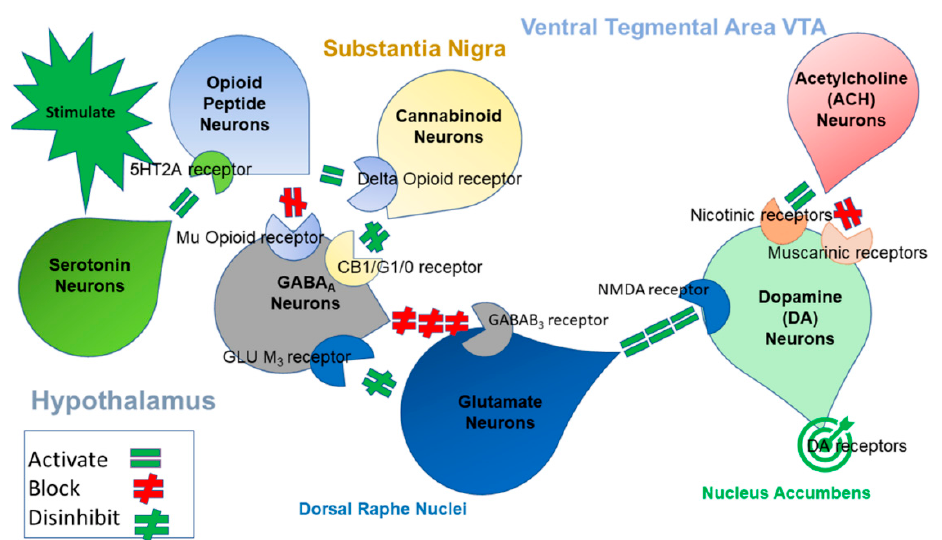
Figure 1. illustrates the interaction of at least six major neurotransmitter pathways involved in the brain reward cascade (BRC). In the hypothalamus, environmental stimulation causes the release of serotonin, which in turn, via, for example, 5HT-2a receptors, activates (the green, equal sign), the subsequent release of opioid peptides into the hypothalamus. Then, the opioid peptides have two distinct effects, possibly via two different opioid receptors. (A) inhibits (the red hash sign) through the mu-opioid receptor (possibly via enkephalin) and projects to the substantia nigra to GABA A neurons. (B) stimulates (the green, equal sign) cannabinoid neurons (e.g., anandamide and 2-archy- donoglcerol) through beta-endorphin linked delta receptors, which in turn inhibit GABA A neurons at the substantia nigra. cannabinoids, primarily 2-archydonoglcerol, when activated, can also indi- rectly disinhibit (the red hash sign) GABA A neurons in the substantia nigra through activation of G1/0 coupled to CB1 receptors. Similarly, glutamate neurons located in the dorsal raphe nuclei (DRN) can indirectly disinhibit GABA A neurons in the substantia nigra by activating GLU M3 re- ceptors (the red hash sign). GABA A neurons, when stimulated, will, in turn, powerfully (the red hash signs) inhibit ventral tegmental area (VTA) glutaminergic drive via GABAB 3 neurons. Finally, glutamate neurons in the VTA will project to dopamine neurons through NMDA receptors (the green, equal sign) to preferentially release dopamine at the NAc shown as a bullseye indicating well-being (with permission Blum et al. [2]). 2. Reward Deficiency Syndrome Index (RDSI) and Genetics Co-occurrences, similarities in the phenomenological and behavioral appearance, and empirical studies of some shared psychological and molecular mechanisms of addic- tive behaviors indicate a more integrative approach to the concept of addictive behaviors. The point of a number of studies was to scrutinize the possible genetic overlaps between different types of substance use, behavioral addictions, and other compulsive behaviors. A genetic association analysis was carried out as a part of the PGA study [12,13], assessing various kinds of addictions in a sample of 3003 adolescent participants. The genetic asso- ciation analyses targeted 32 single-nucleotide polymorphisms (SNPs) and four substances of abuse (alcohol, tobacco, marijuana, and other drugs), and seven potentially addictive behaviors: internet addiction, gaming, social networking sites addiction, gambling disor- der, exercise addiction, trichotillomania, and eating disorders. The association analysis revealed 29 nominally significant associations, of which nine survived the FDRbl correc- tion for multiple testing. Four out of these nine significant associations were observed between a FOXN3 SNP and various addictions: rs759364 showed an association with the frequency of alcohol consumption and the mean scores of internet use, gaming, and exer- cise addiction questionnaires. In addition, significant associations have been found be- tween glial cell derived neurotrophic factor (GDNF) rs1549250, rs2973033, Cannabinoid Recep- tor-1 ( CNR1) rs806380 , and Dopamine receptor D2 ( DRD2)/ ankyrin repeat and kinase domain containing 1 (ANKK1) rs1800497 variants and the “lifetime other drugs” variable.